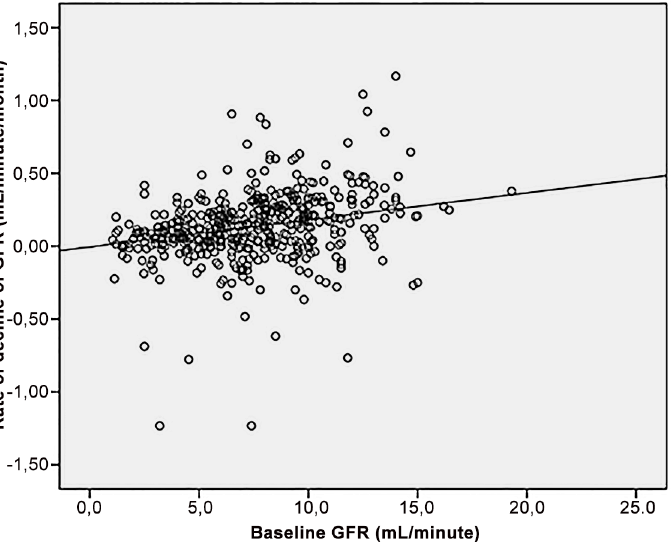
Fig 1. Correlation between baseline GFR and its rate of decline during follow-up on